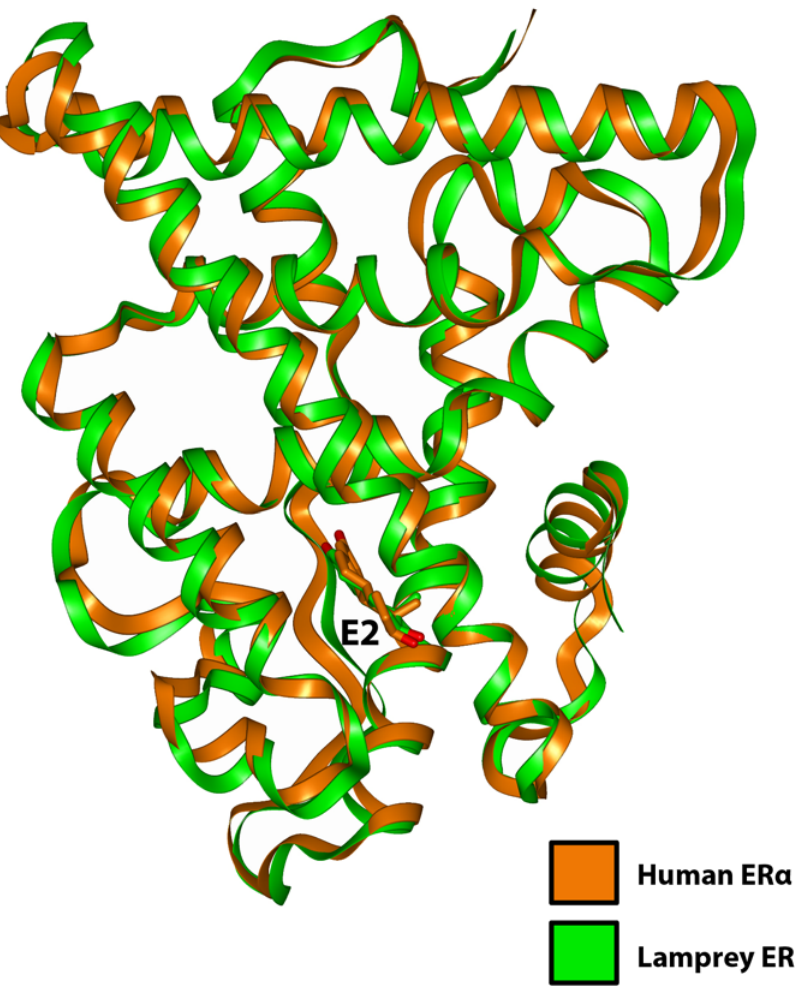
Figure 3. Overlap of 3D model of lamprey ER with human ER a . The 3D model of lamprey ER with estradiol was superimposed on human ER a . There is excellent overlap. The root mean square deviation between the C a backbone of human ER a and lamprey ER is 1.4 A˚.